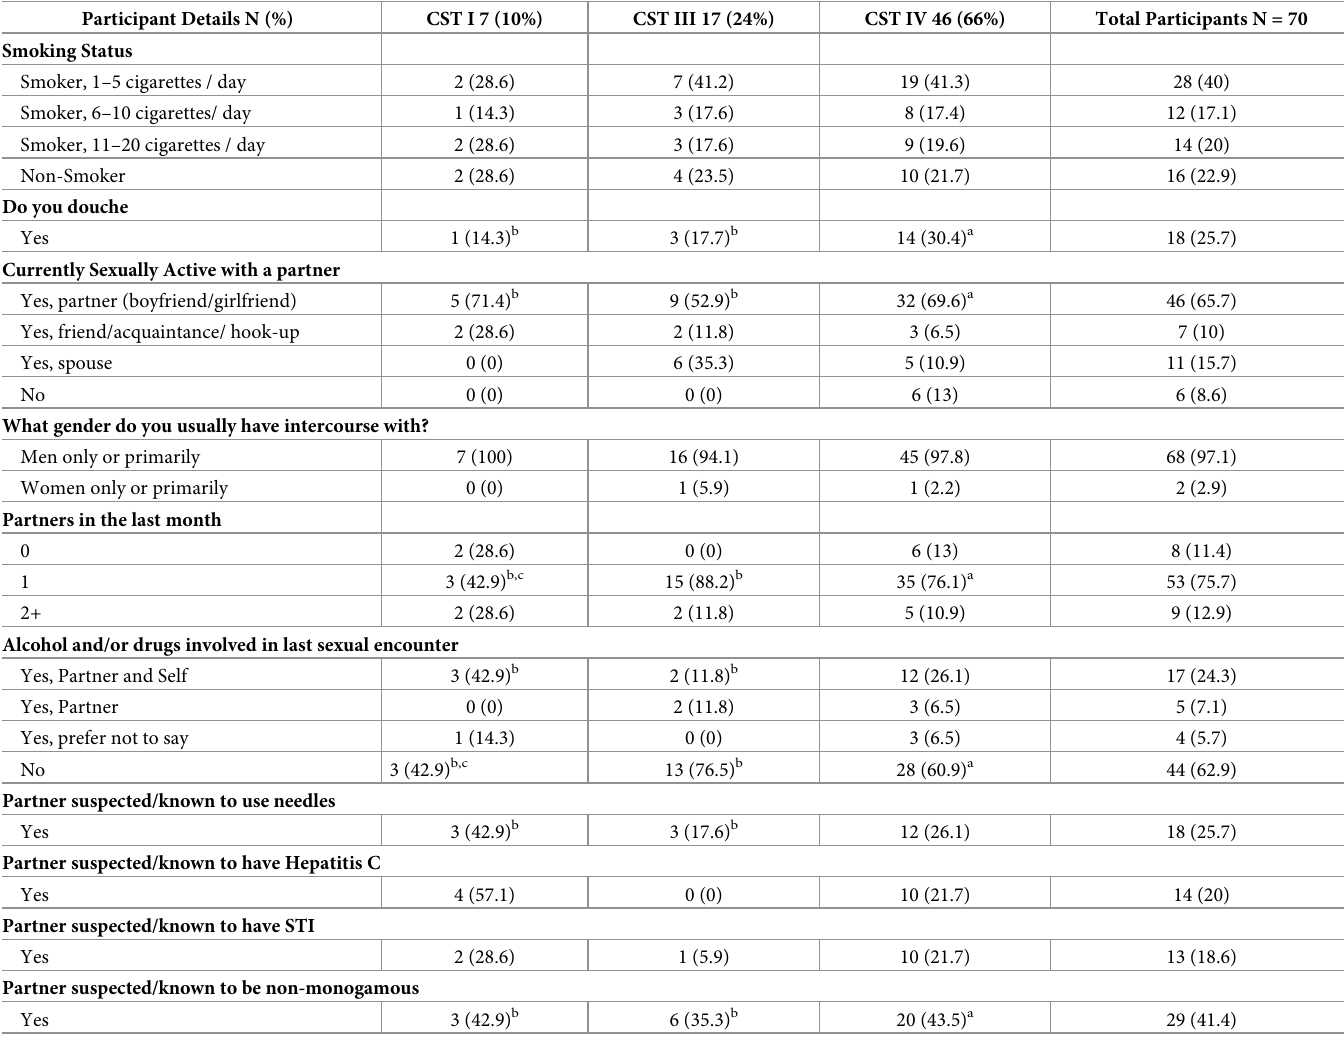
Table 3. Participant lifestyle and sexual